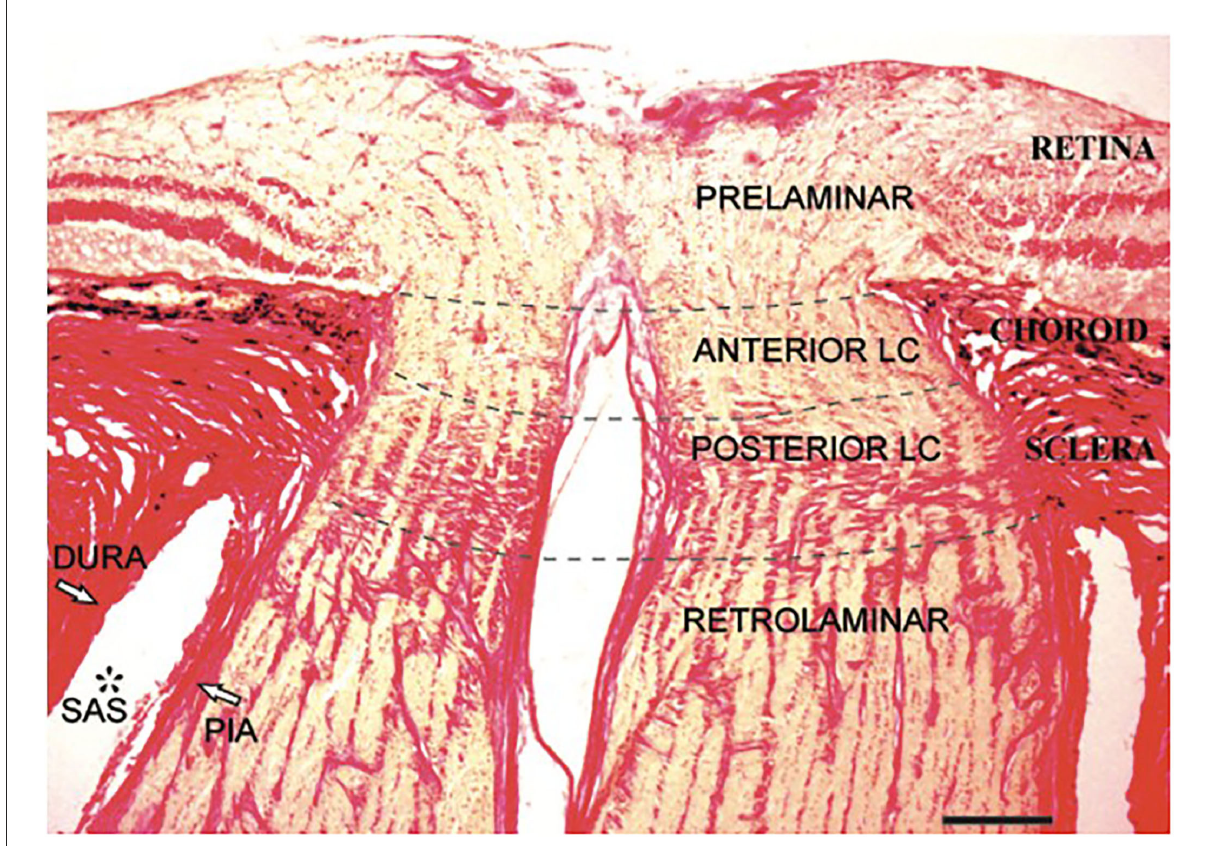
FIGURE3 Histological section of the human intraocular portion in Van Gieson stain. LC: lamina cribrosa [Reproduced from Kang et al. (30) with permission from the